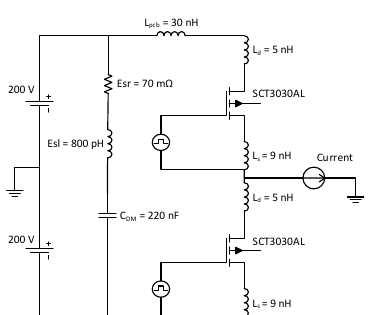
Figure 2. Diagram of the simulation performed in Spice to extract the switching energy curves, with addition of parasite inductances.